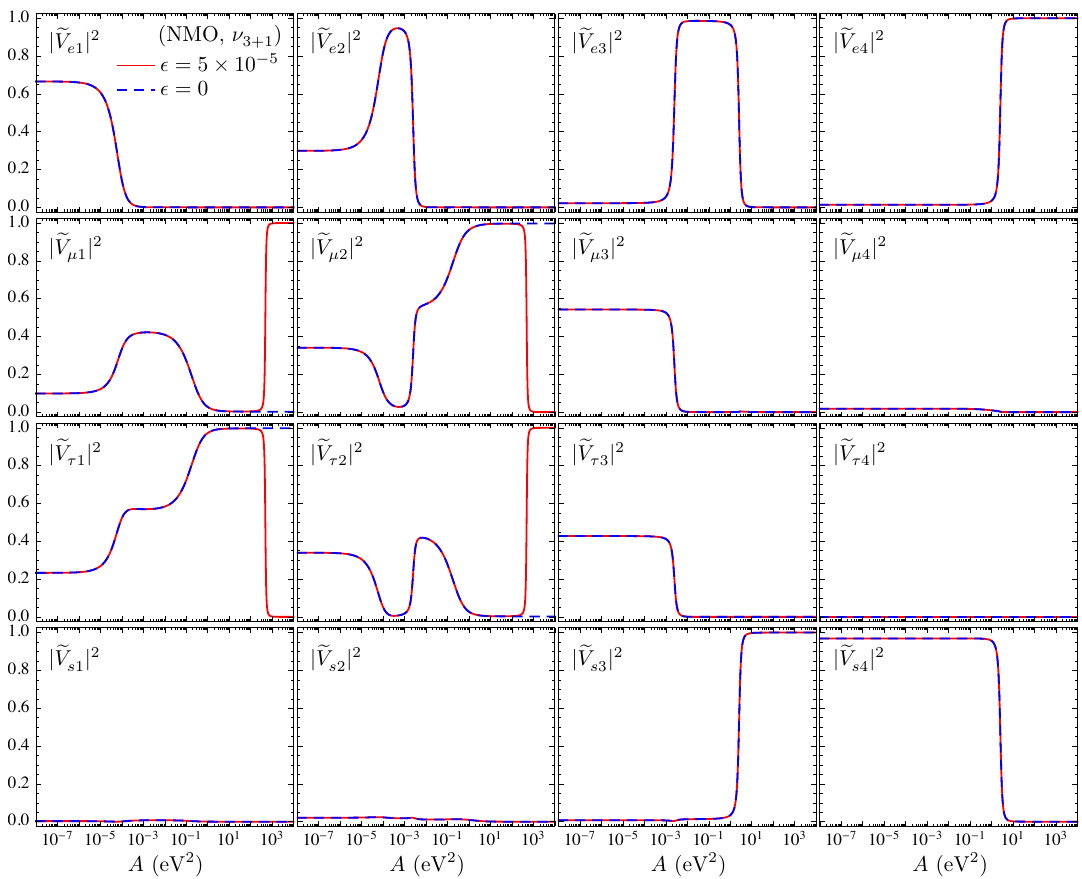
Figure 8 . In the (3 + 1) mixing scheme, the illustration of how 1 ; 2 ; 3 ; 4) evolve with the matter e(cid:11)ect parameter A in the case (NMO ; (cid:23) radiative corrections, where we typically take the best-(cid:12)t values of ( (cid:18) and for the active-sterile neutrino mixing part ( (cid:18)